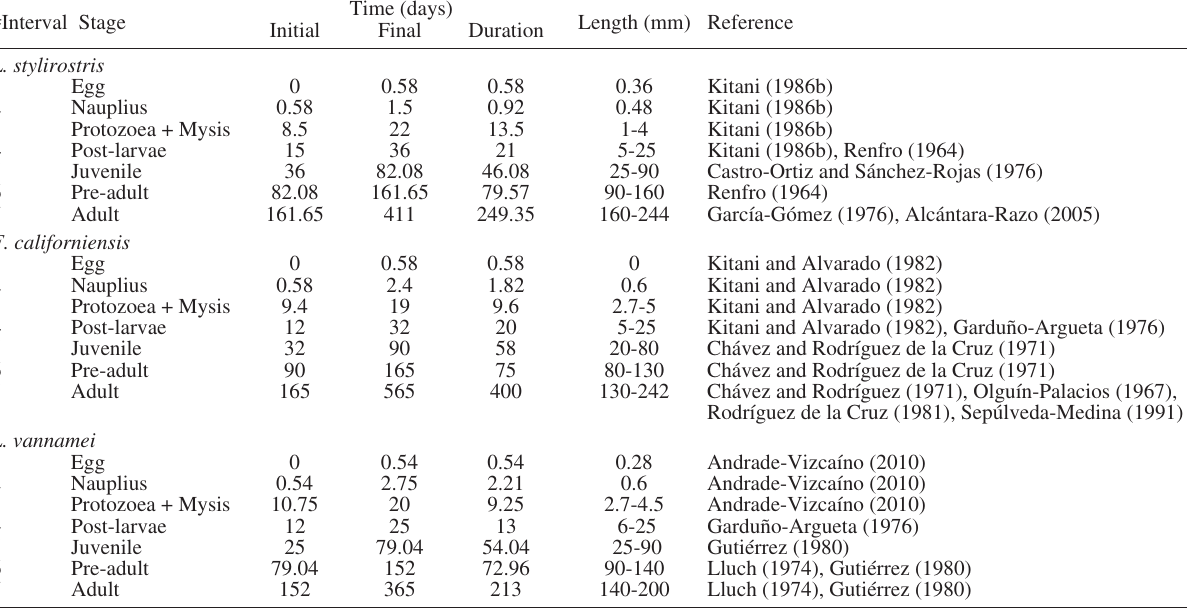
Table 4. – Gnomonic division of the life history for the white ( L. vannamei ), blue ( L. stylirostris ), and brown ( F. californiensis ) shrimps, showing correspondence with the observed information. #Interval